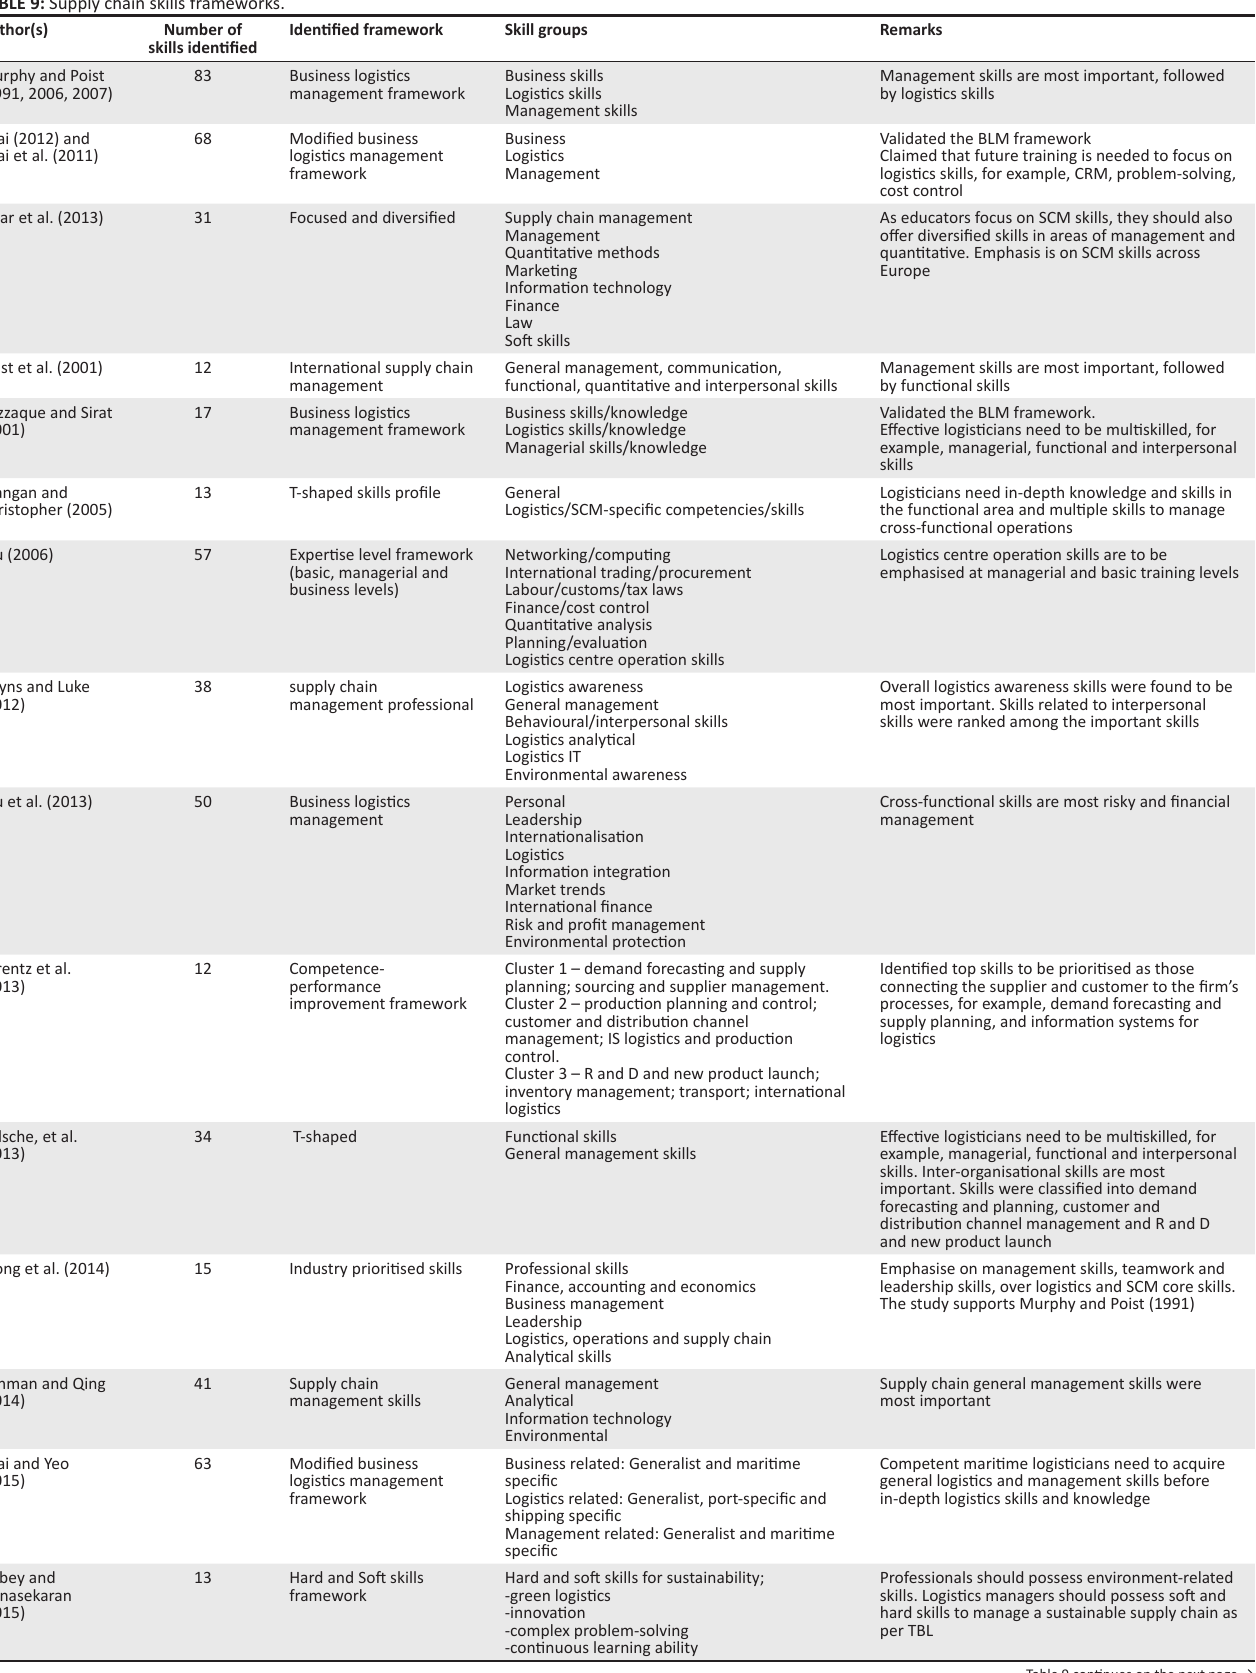
TABLE 9: Supply chain skills